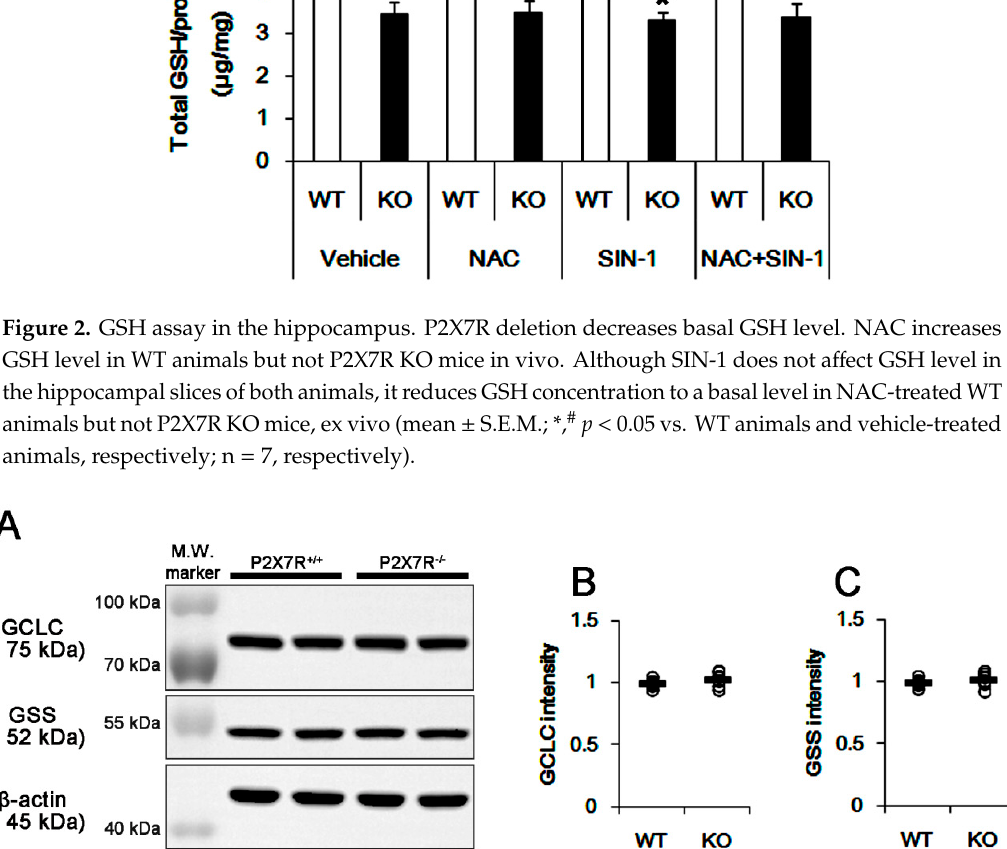
Figure 3. Effects of P2X7R deletion on expression of GSH synthetic enzymes. P2X7R deletion does not affect GCLC and GSS expressions. ( A ) Representative Western blots of GCLC and GSS expressions. ( B – C ) Quantification of GCLC ( B ) and GSS ( C ) levels based on Western blot data. Open circles indicate each individual value. Horizontal bars indicate mean value (mean ± S.E.M.; n = 7, respectively).